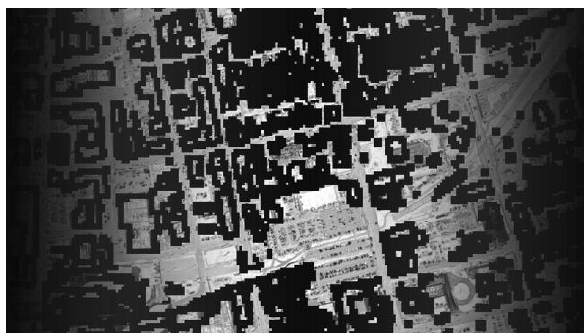
Figure 7. A conceptual representation of final constraint mask